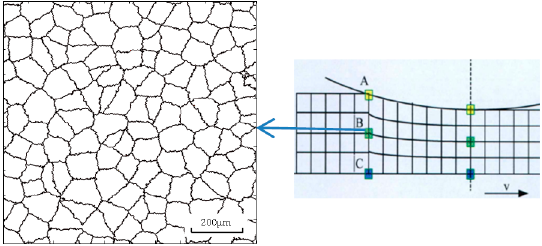
Figure 2. Initial microstructure of 7055 aluminum alloy (v represents rolling direction; A, B and C represent point at upper surface, center and lower point of the